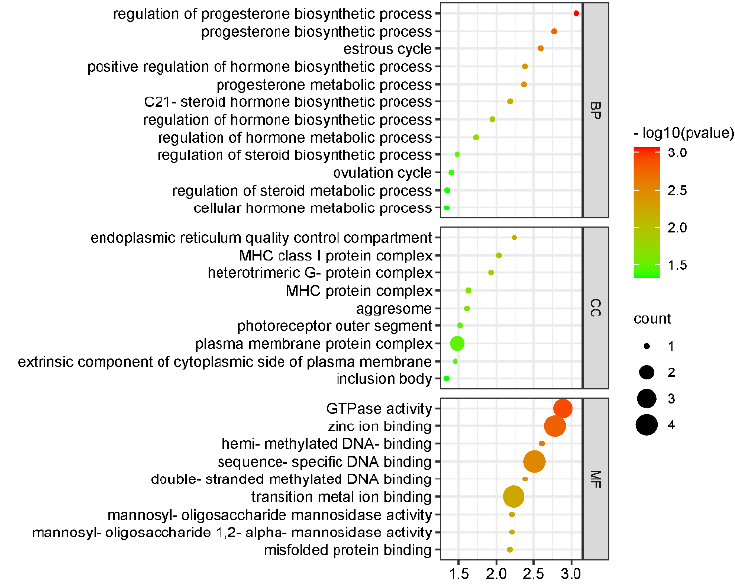
Figure 6. GO analysis of miRNA.